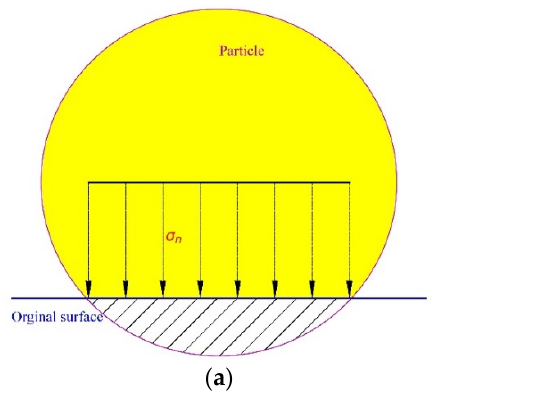
Figure 16. Illustration of stress over disc. ( a ) Original surface and ( b ) deformed surface.